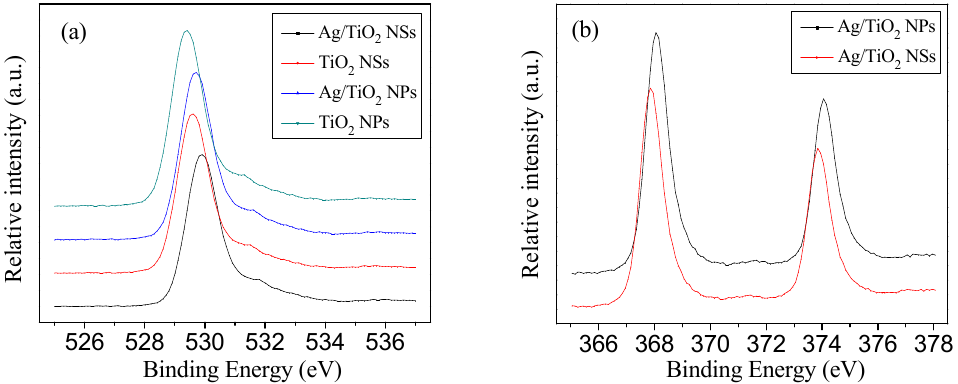
Figure 6. XPS spectra of O 1s for four catalysts ( a ) and Ag 3d for Ag/TiO 2 (NSs and NPs) ( b ).